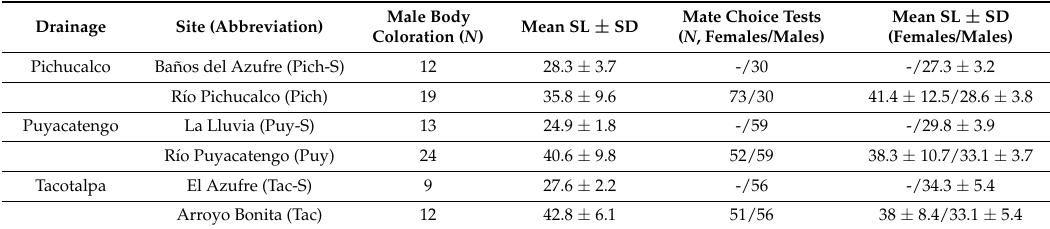
Table 1. Study sites, sample sizes ( N ), and standard lengths (SL) of Poecilia spp. collected for the analyses of male body coloration and cross-drainage mate choice